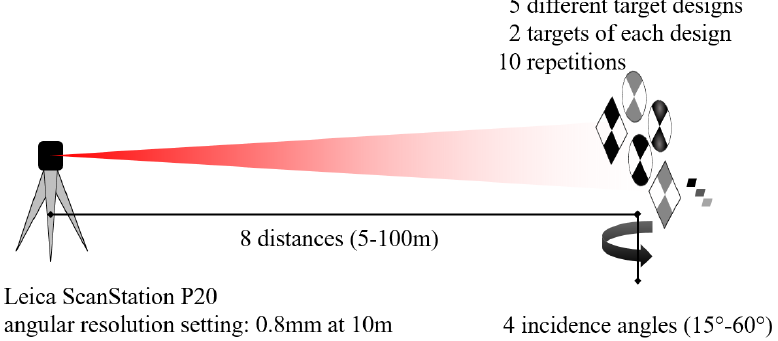
Figure 8. Schematic drawing of the experimental setup for the investigation of the target design’s